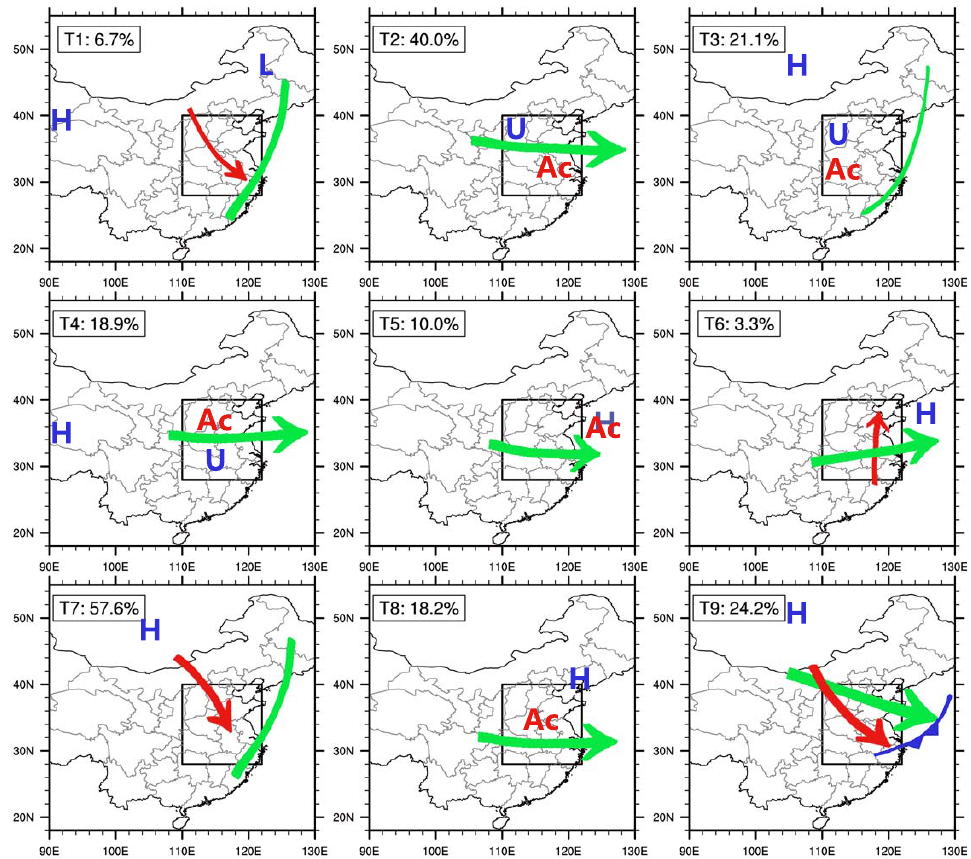
Figure 17. Schematic diagram of nine circulation types. The surface, 850hPa level and 500hPa level are shown by blue, red and green marks respectively. At the surface, “H/L” is the location of high-/low-pressure centres and “U” means a uniform pressure field in eastern China. At 850hPa, “Ac” represents for the existence of an anticyclone, and the red arrow is used to indicate the wind direction and speed. At 500hPa, the green marks are used to indicate the direction of upper air flow or the location of the trough line.